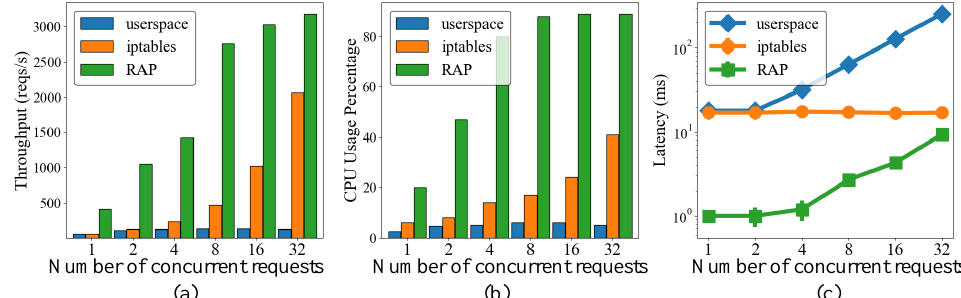
Figure 7. Effect of centralization requests on the cluster performance: ( a ) throughput, ( b ) latency, and ( c ) application resources.